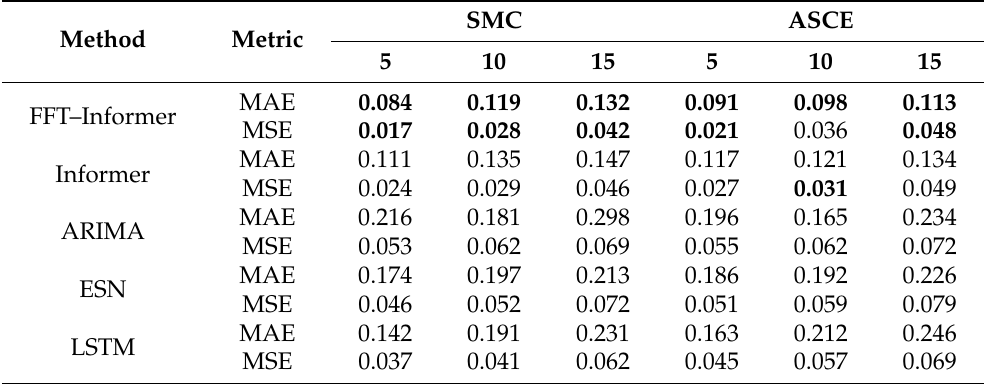
Table 4. Comparison of long-term forecasting methods. (Bold value is the minimum